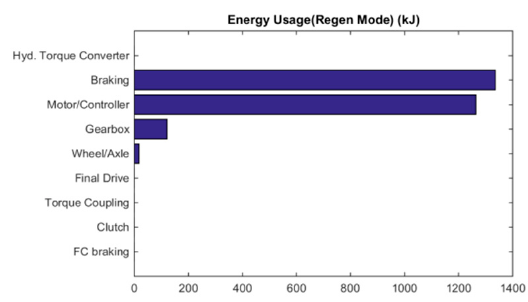
Figure 12. Energy use power mode. Energies 2020 , 13 , x FOR PEER REVIEW